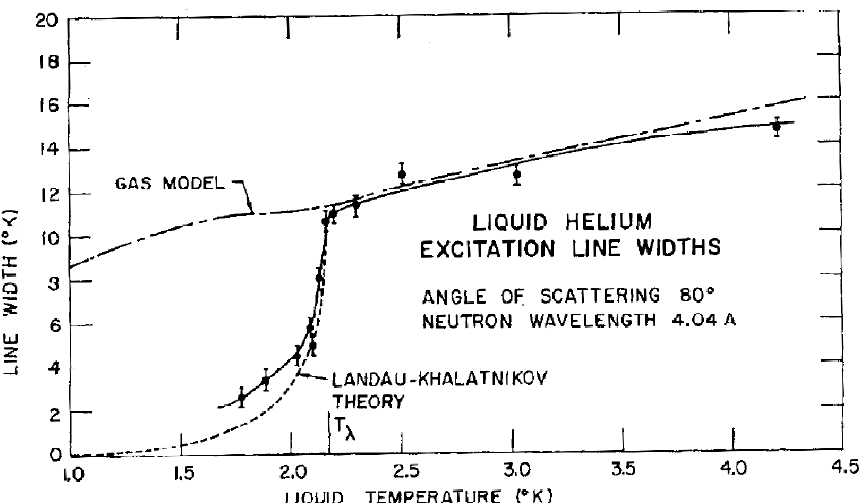
Figure 41. The temperature variation of the full-width at half-height of the phonon–roton excitation peak in liquid helium close to the roton minimum. The solid curve has been drawn through the points as a guide to the eye. The broken curve gives the calculated widths for a gas with an effective mass close to 4 above the λ -point. The width decreases to around 2.5 at the lowest temperature. The dotted curve represents the theoretical widths on the basis of the Landau–Khalatnikov theory. This figure is taken from Figure 8 of ref. [100]. Copyright by the American Physical Society.